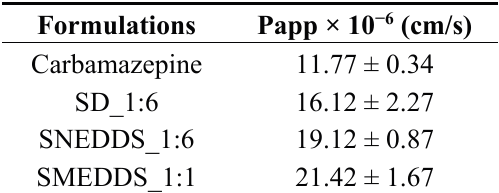
Table 2. PAMPA test: values of apparent permeability coefficients (Papp) of tested formulations and pure